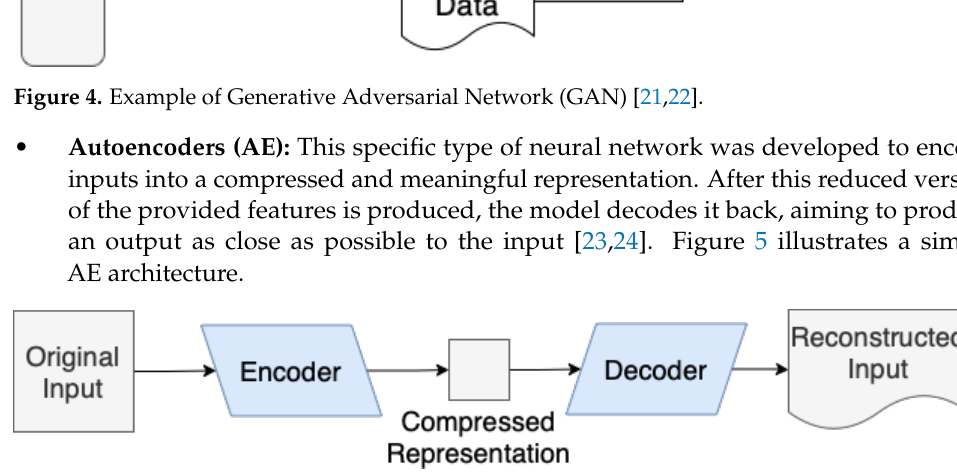
Figure 5. Example of Autoenconder (AE)